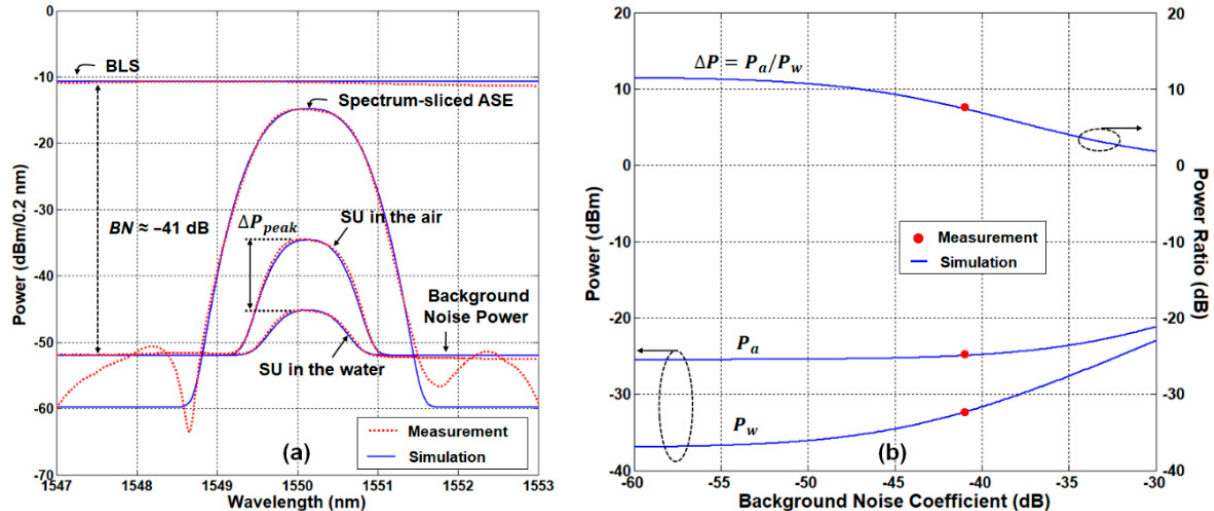
Figure 2. Fresnel reflections in the air and water. ( a ) Measured and simulated optical spectra for single channel. ( b ) Fresnel reflection power ratio ( ∆ P = P a / P w ) according to the background noise coefficient.